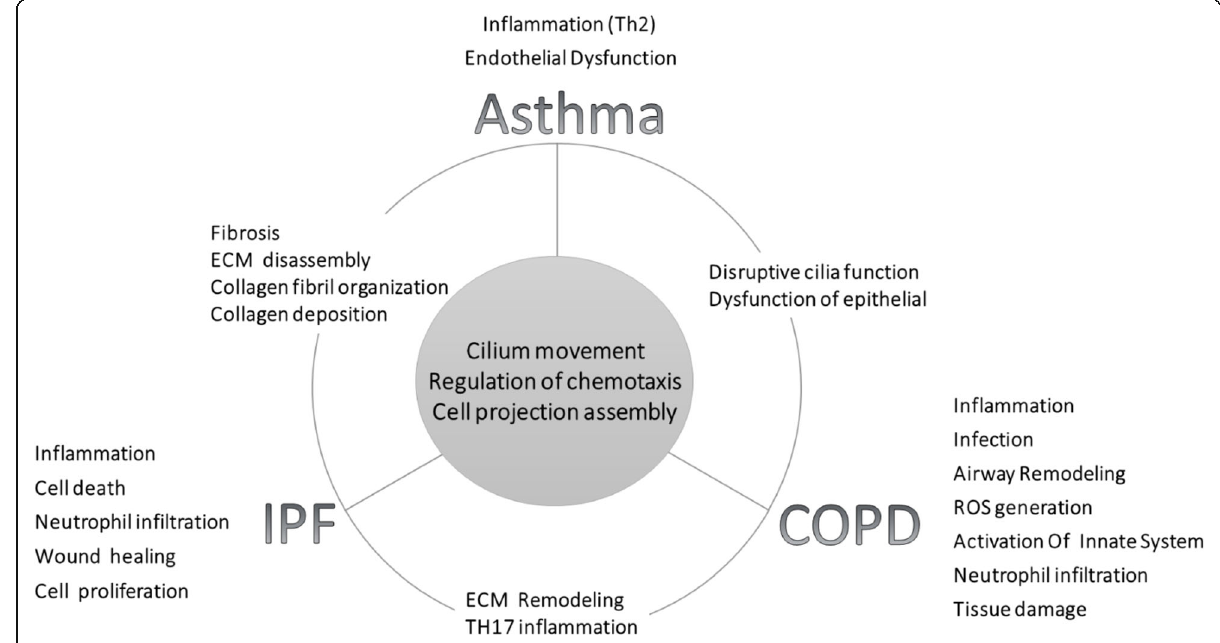
Fig. 6 Summary of functional enrichment of candidate disease-specific and consensus modules among three